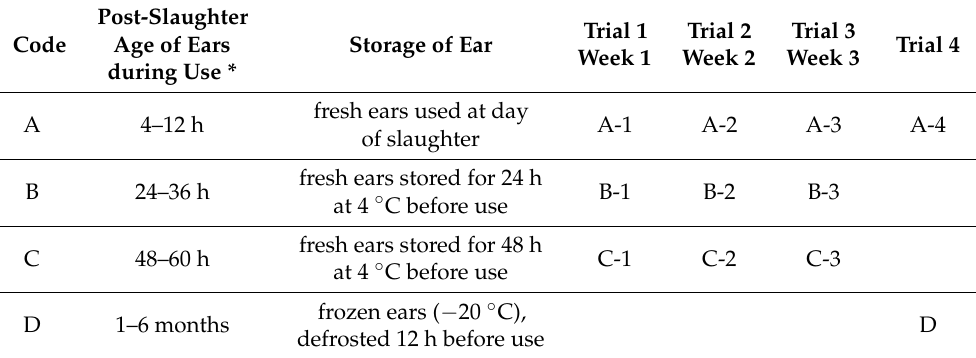
Table 2. Experimental design of the